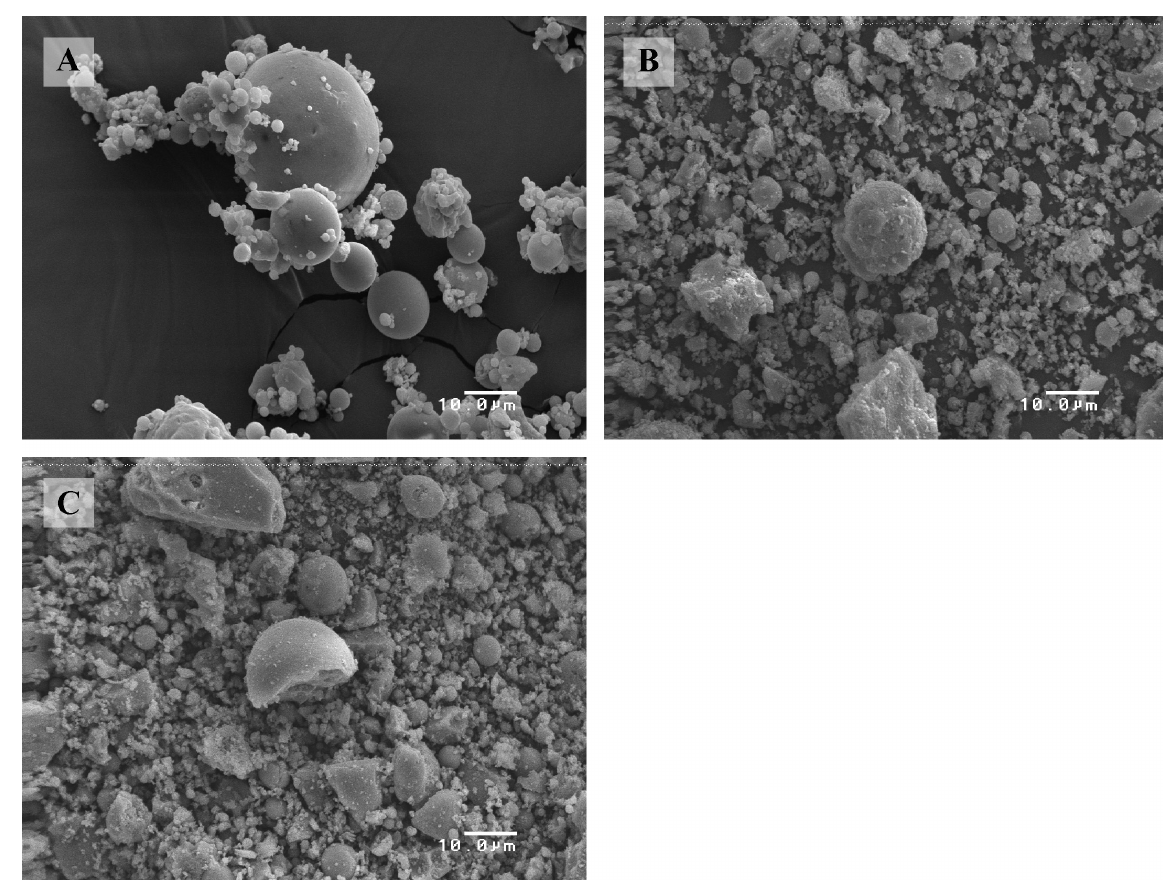
IgnitiondatashownintheTable1.Theoriginofweightloss of all samples that occurred after 970 ∘ C is related to desul- furization. All samples show a weight gain from 700 ∘ C up to 950 ∘ C caused by oxidation of iron.